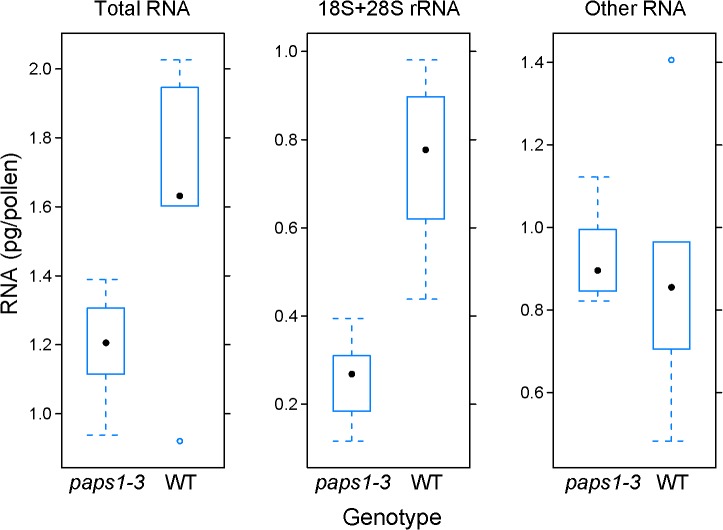
Role of PAPS1 in ribosome biogenesis.Quantification of total RNA (left), combined 18S and 28S rRNA (middle), and remaining non-ribosomal RNA (right) in pg per pollen grain from paps1-3 mutant and PAPS1 pLat52::DsRED wild-type pollen grains produced by paps1-3—/ PAPS1 pLat52::DsRED transheterozygous plants. Pollen grains were flow-sorted based on DsRED fluorescence and extracted total RNA was subjected to Bioanalyzer quantification. RNA amounts were related to the known number of pollen grains in the sorted fractions. Values represent five biological replicates; black dot is the median value, open blue circles show outliers as determined using the R/lattice boxplot.stats function.